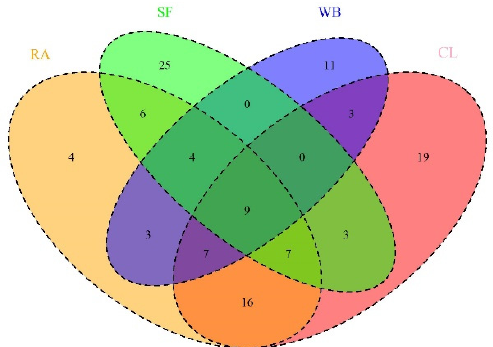
Figure 7. Venn diagram showing the number of unique and shared species among the different Table 3. Pairwise comparisons of the bird communities among four different habitats and seasons in the study